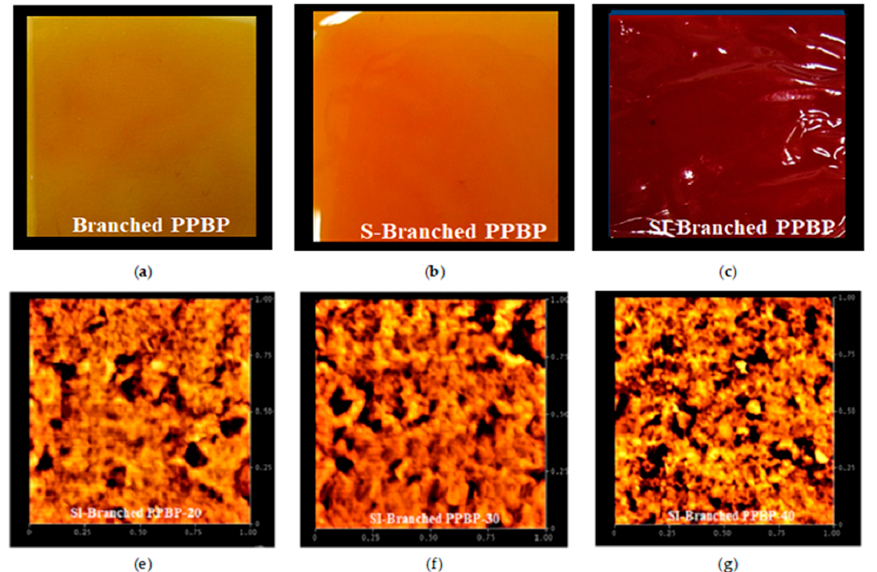
Figure 7. Images for ( a ) branched PPBP, ( b ) S-branched PPBP, and ( c ) SI-branched PPBP polymers and atomic force microscopy images for ( e ) SI-branched PPBP-20, ( f ) SI-branched PPBP-30, and ( g ) SI-branched PPBP-40 polymers.